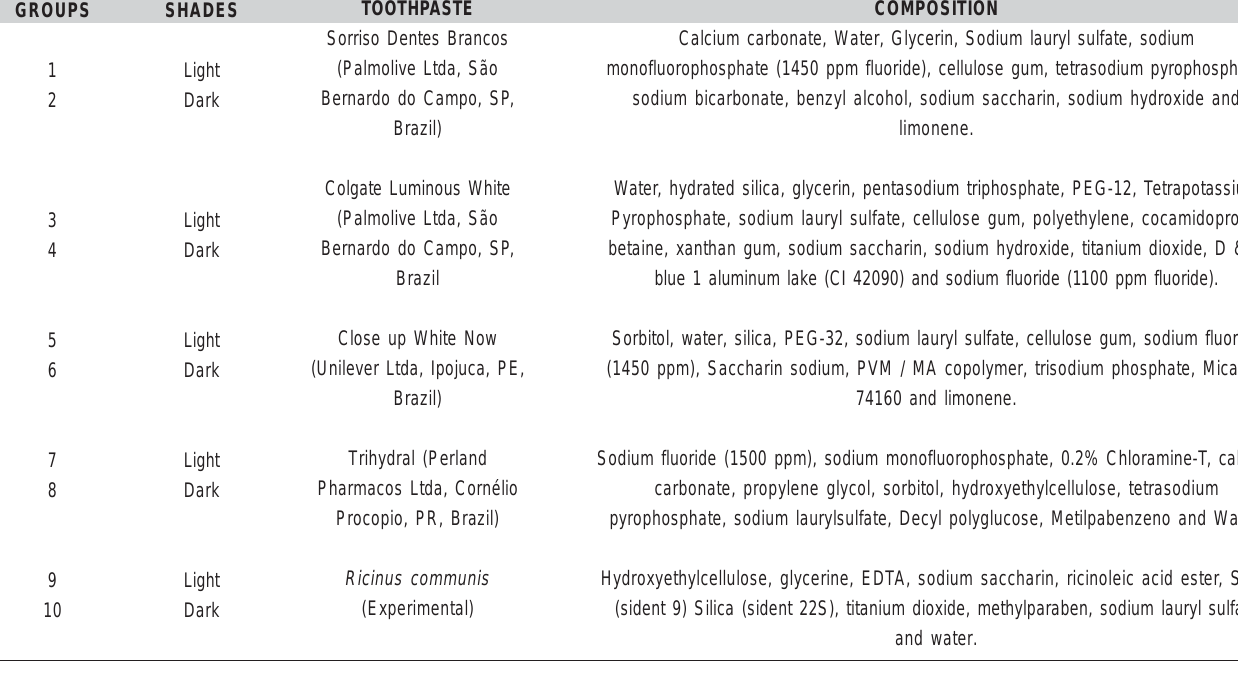
Table 1. Groups formed according to tooth shade and dentifrice used in the study.